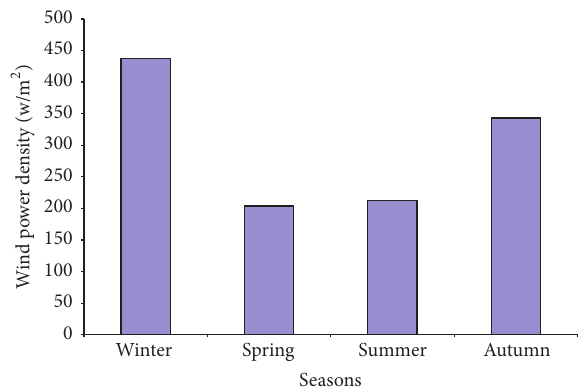
Figure 8: Values of seasonal mean wind power density for the period 1980–2009 in the ECS, unit: w/m 2 .